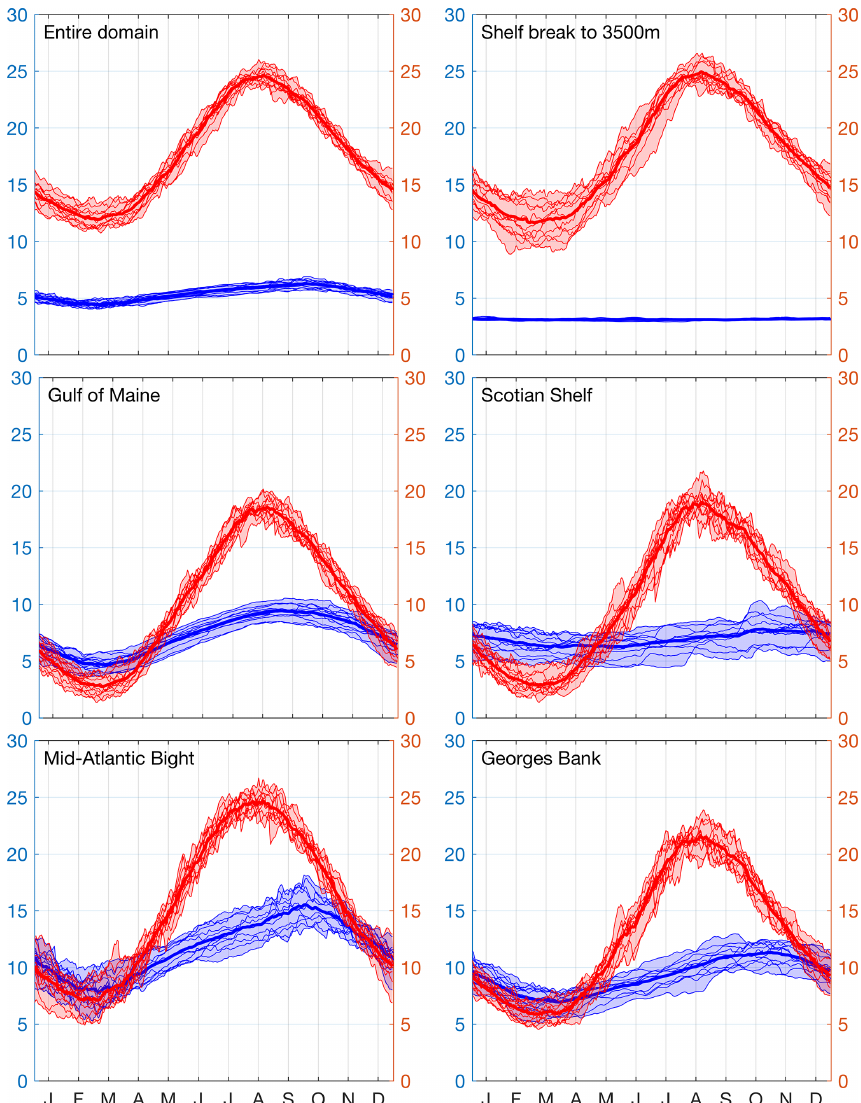
Figure 10. Ensemble seasonal cycles for subregions defined in Fig. 6 for 2007–2017 simulation. Red is sea surface temperature; blue is the bottom temperature. Thick line is the 11-year mean; thin lines represent individual years, and the shaded envelope shows the spread of interannual